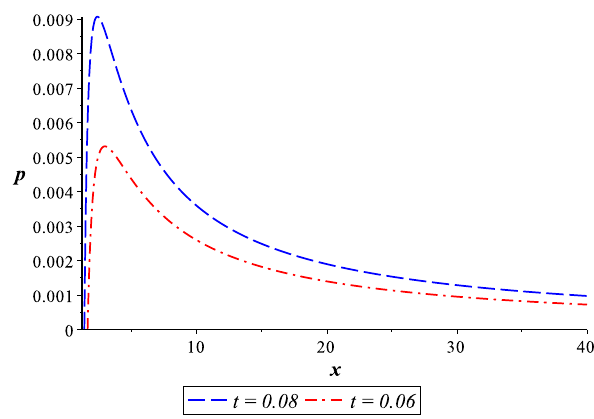
Fig. 5 p − x diagram for the anti-de Sitter case, ω = − 1. Here V ∝ r 3